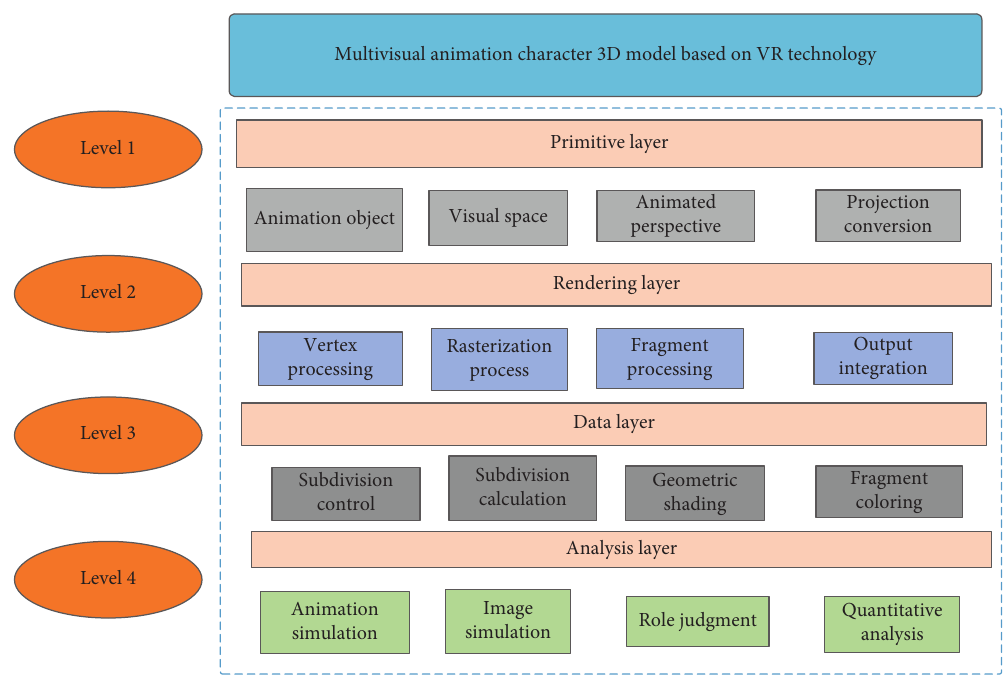
Figure 1: Feature layer of multivisual animation character 3D model based on VR technology.